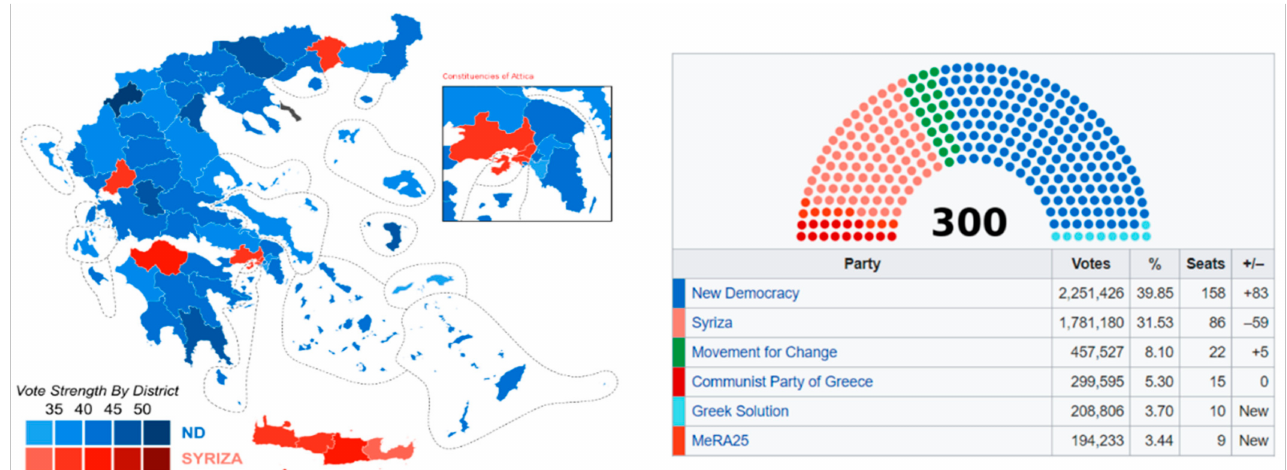
Figure 6. Results of the last Greek legislative election, showing the vote strength of the party winning a plurality in each electoral